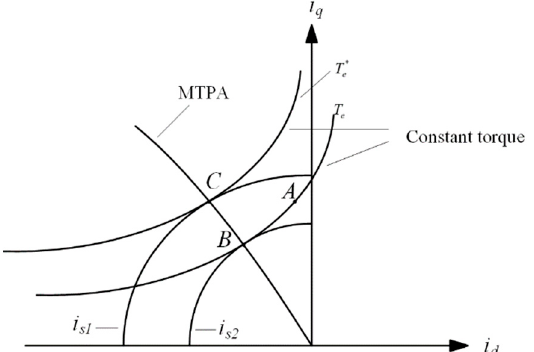
Figure 4. Stator current vector trajectory.